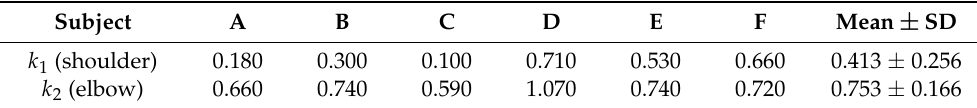
Table 2. Parameters of signal-dependent noise. k 1 and k 2 are coefficients that determine the magni- tude of signal-dependent noise, and indicates the effect of the commanded torque of the subscript number on